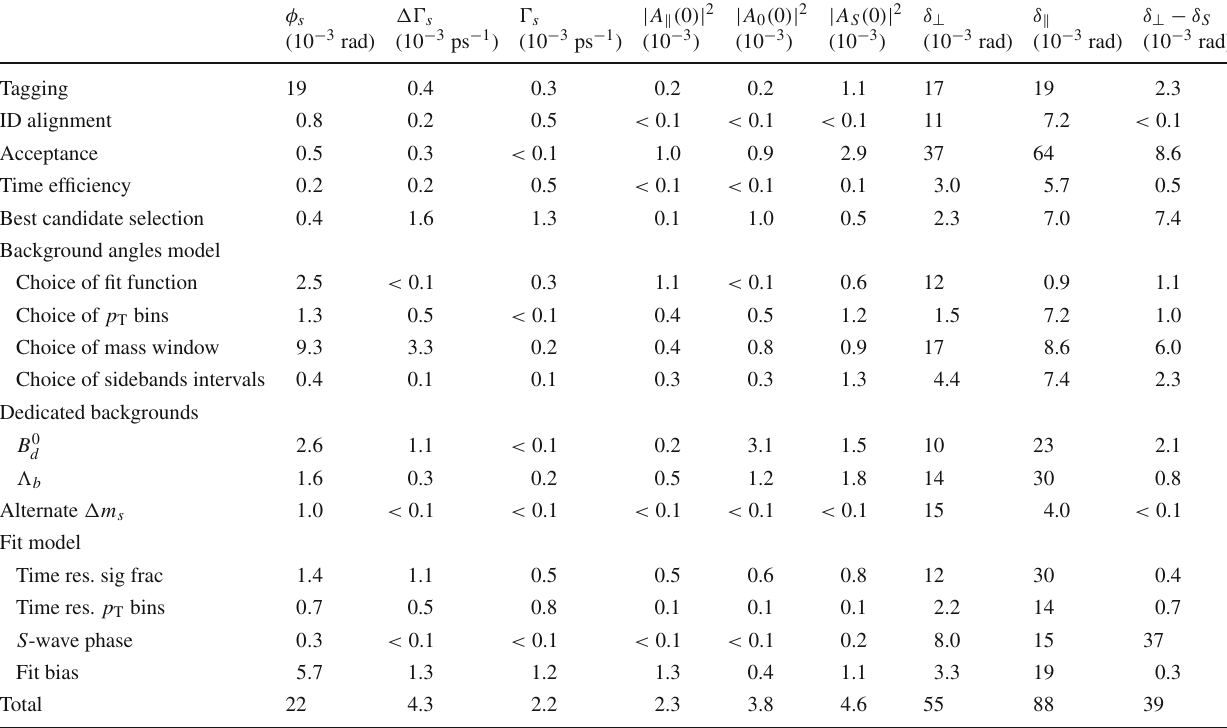
Table 5 Summary of systematic uncertainties assigned to the physical parameters of